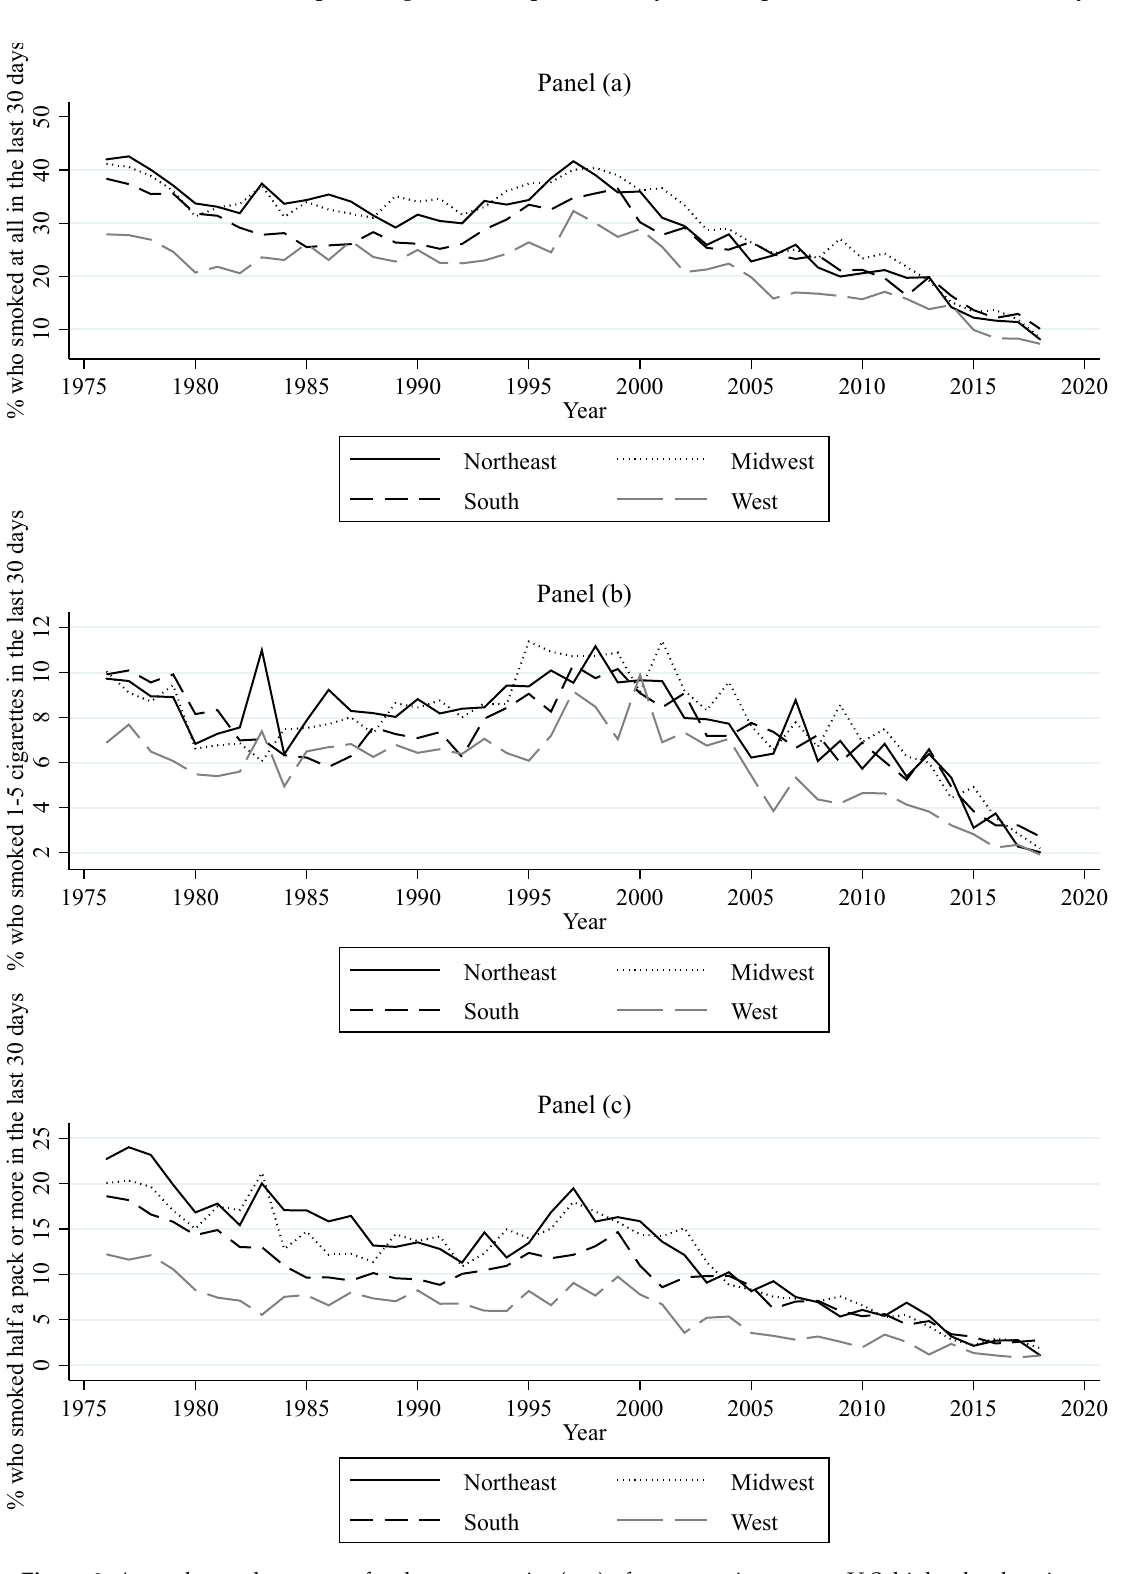
Figure 2. Annual prevalence rates for three categories ( a – c ) of consumption among U.S. high school seniors.